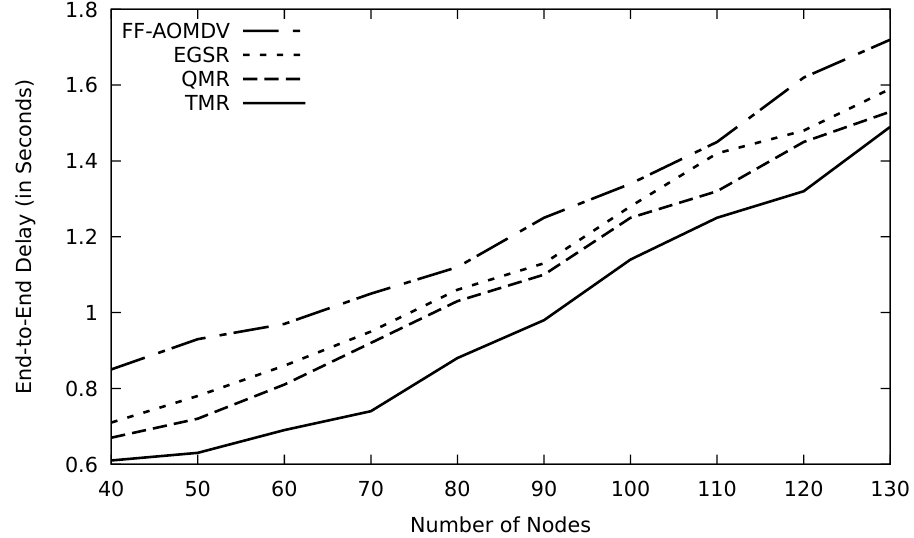
Figure 15. Comparison of FF-AOMDV, EGSR, QMR, and proposed protocol TMR for end-to-end delay with number of